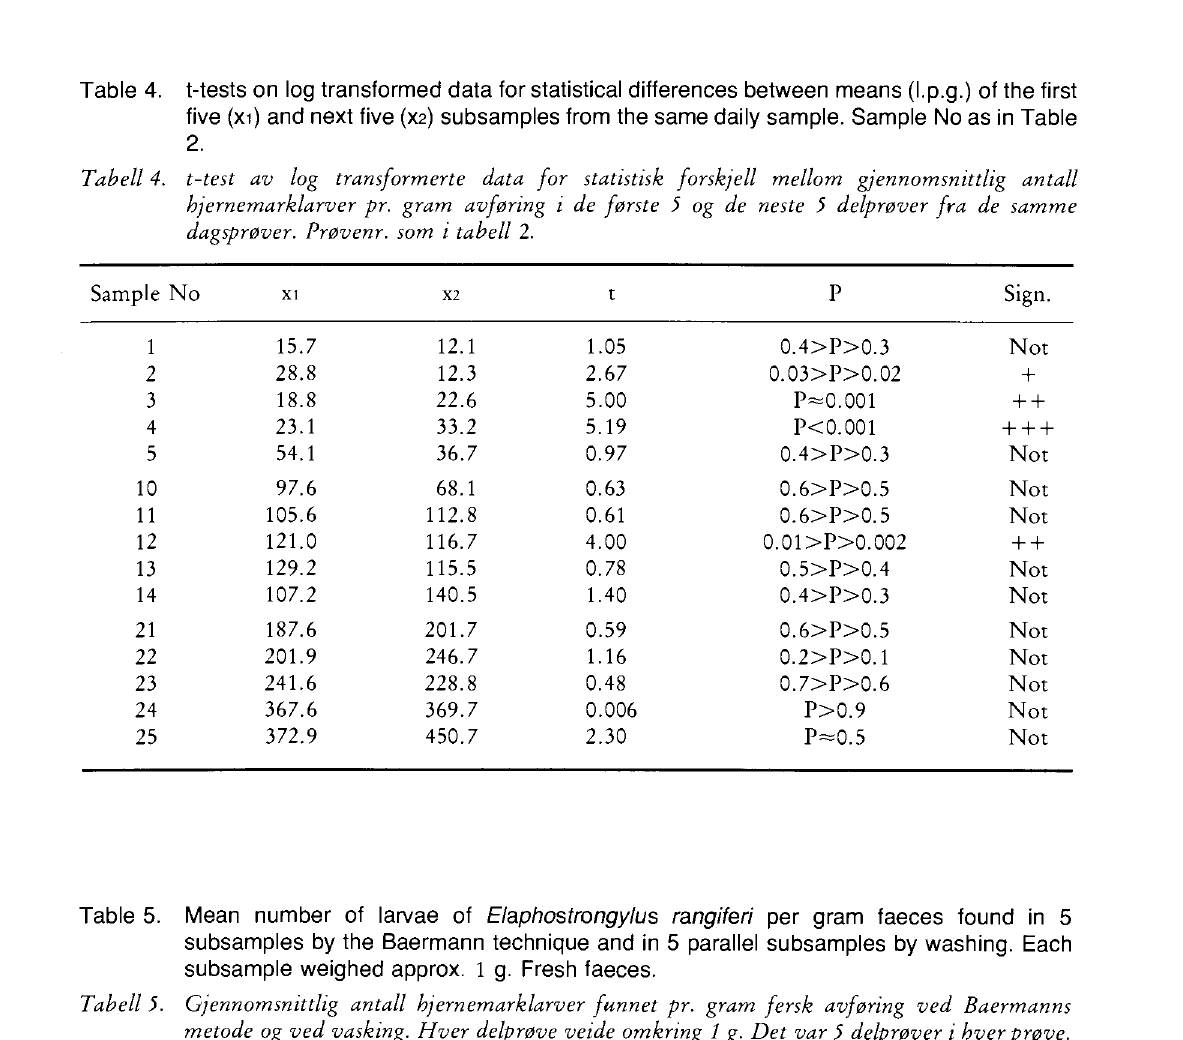
t-tests on log transformed data for statistical differences between means (l.p.g.) of the first five (xi) and next five (X2) subsamples from the same daily sample. Sample No as in Table 2. Tabell 4. t-test av log transformerte